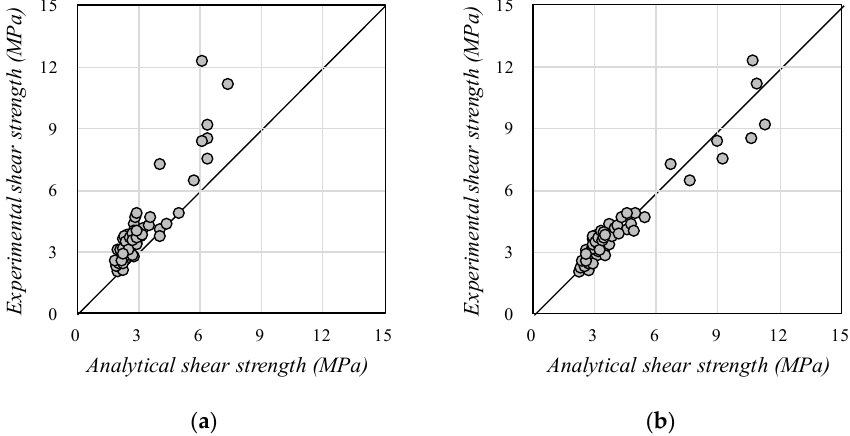
Figure 6. Comparison of experimental and analytical results: ( a ) ACI 318-19; ( b ) proposed model .